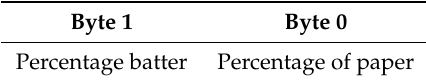
Table 6. Bytes sent by the toilet paper dispenser sensor frame payload in the application layer through the LoRa